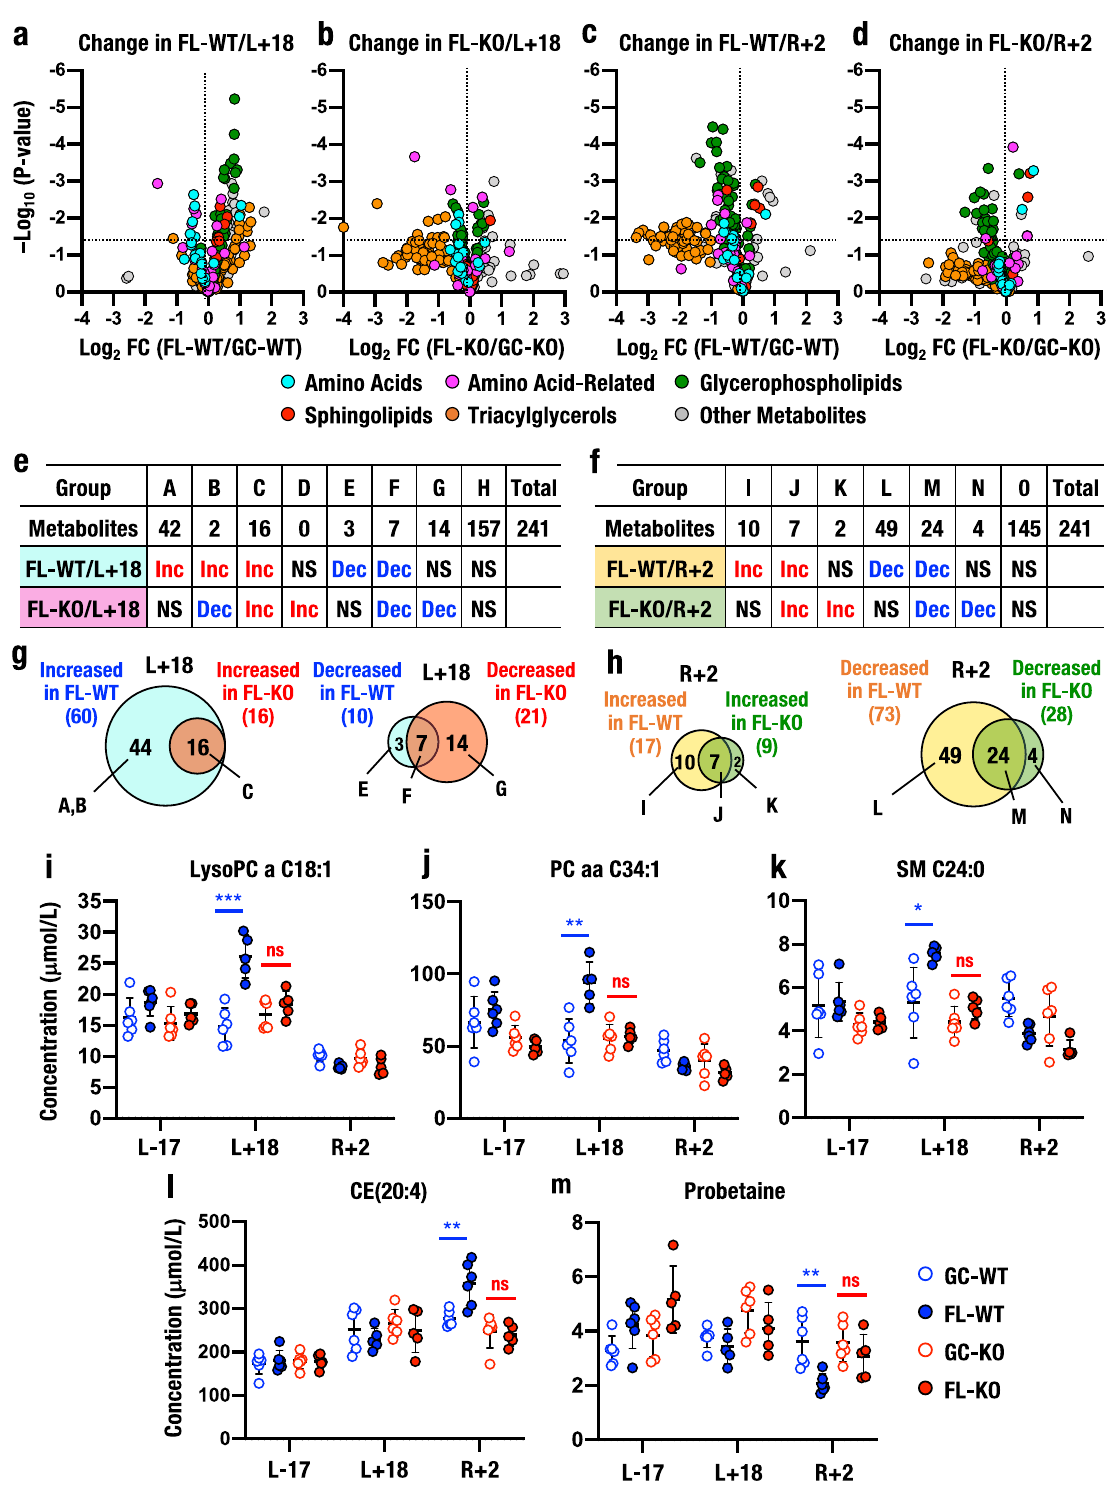
levels detected in FL-WT mice were not observed in FL-KO